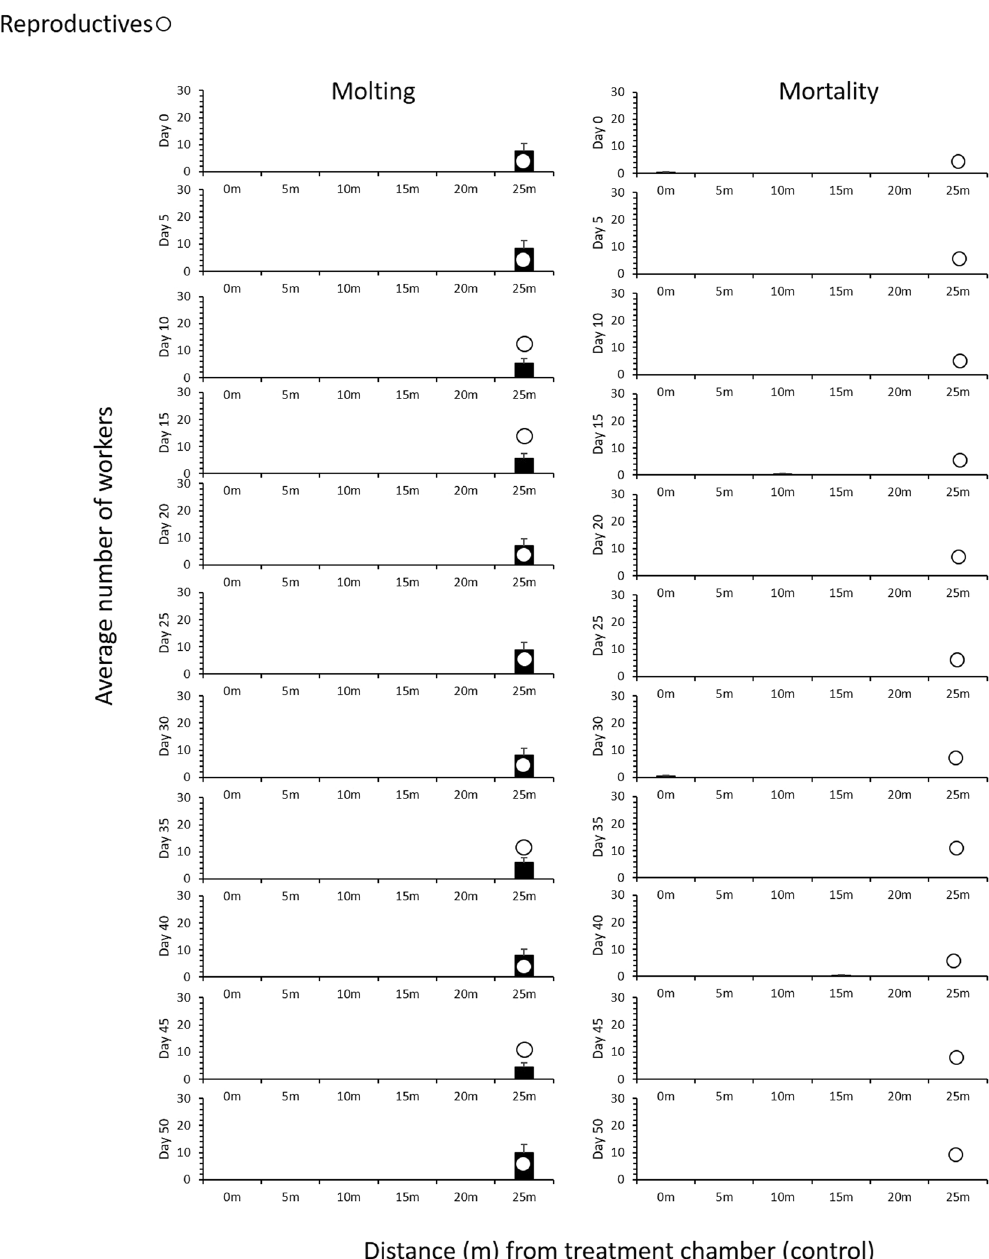
Figure 1. Mean number ( ± S.E) of worker molting (left) and worker mortality (right) in three 6 yr old juvenile colonies ( A , B , and C ) using 25 m long linear foraging arena for